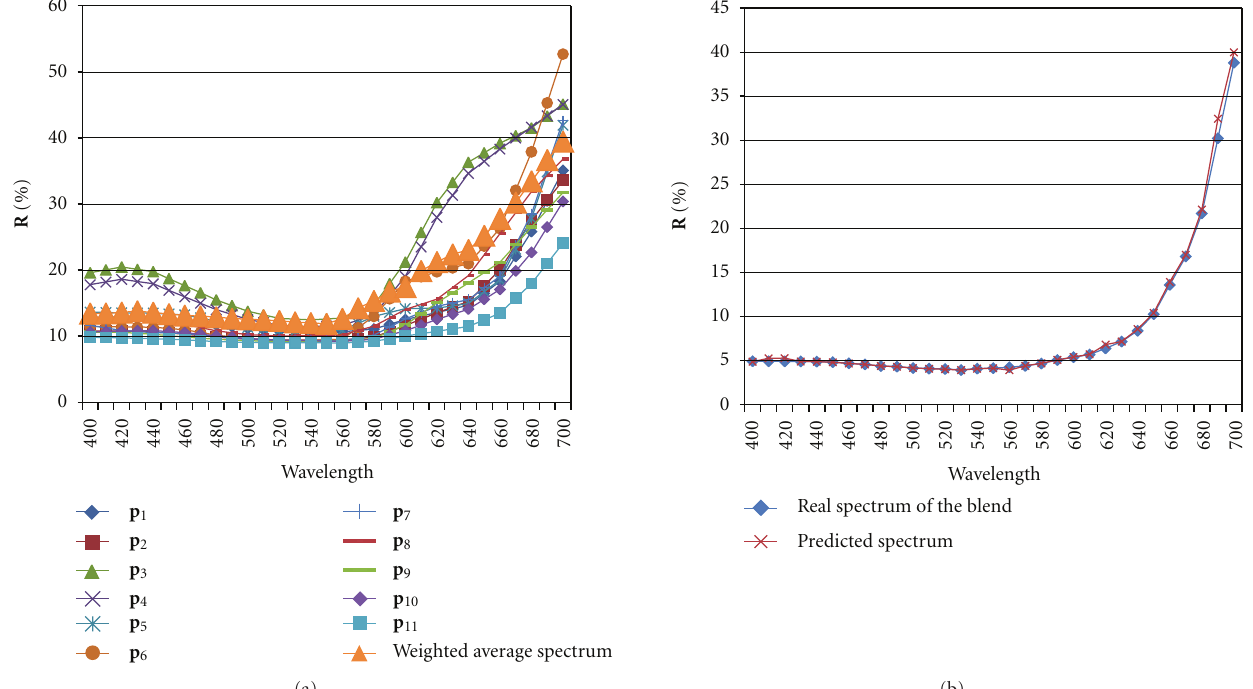
Figure 5: (a) Spectrophotometric response of the 10 fibres composing the blend used for explaining the developed approach. The weighted average spectrum is also provided. (b) comparison between the two vectors R out and R real